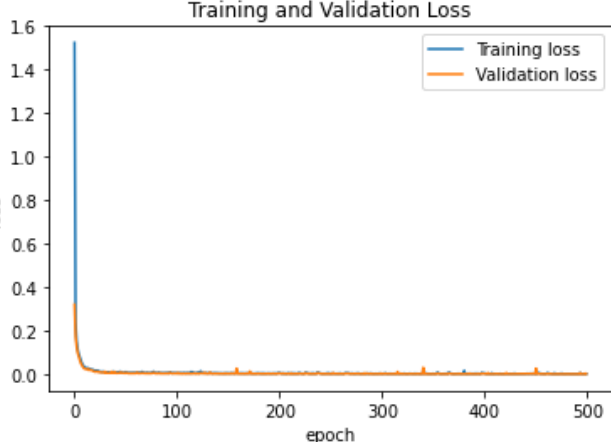
Figure 7. Training and validation loss with 500 epochs.